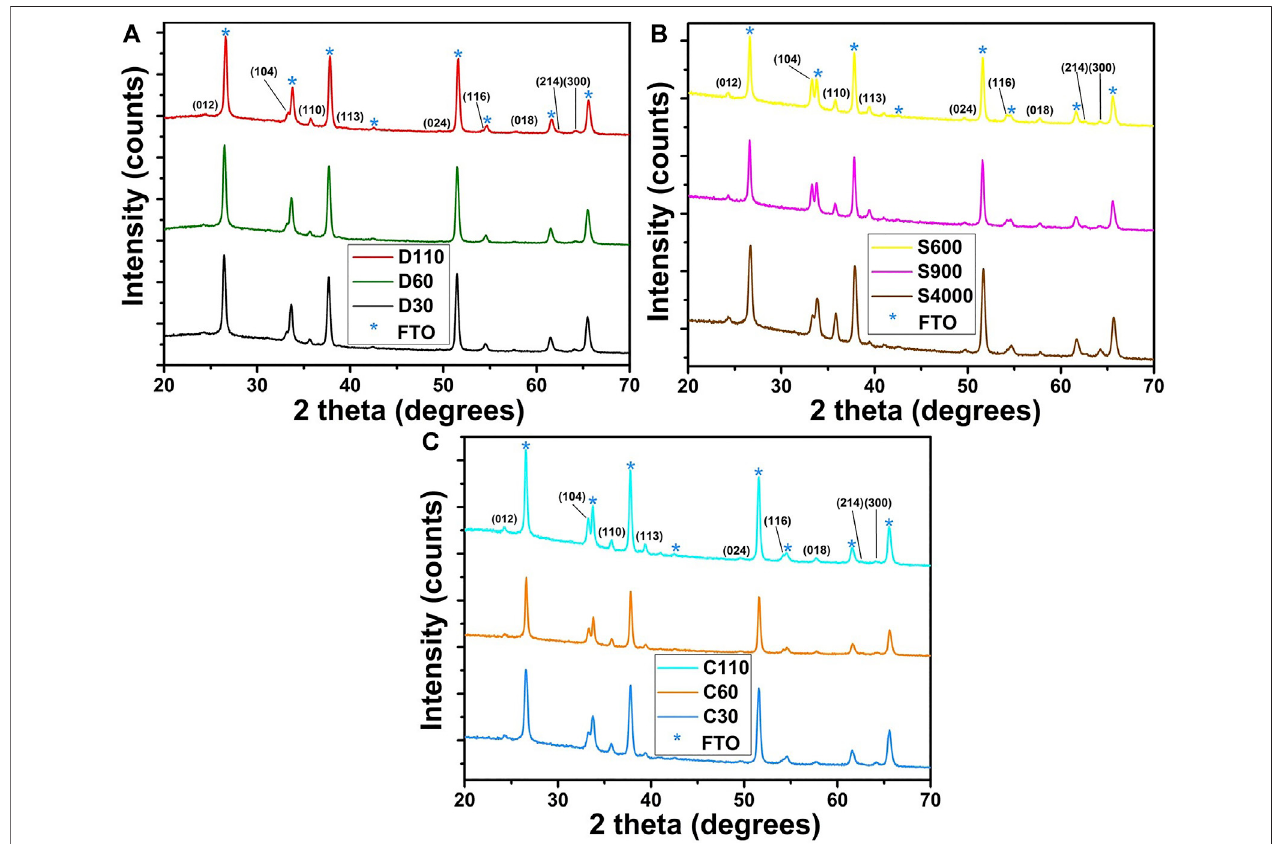
FIGURE 4 | XRD pattern of α -Fe 2 O 3 fi lms prepared using the (A) dip (B) spin and (C) combined dip/spin coating techniques respectively.